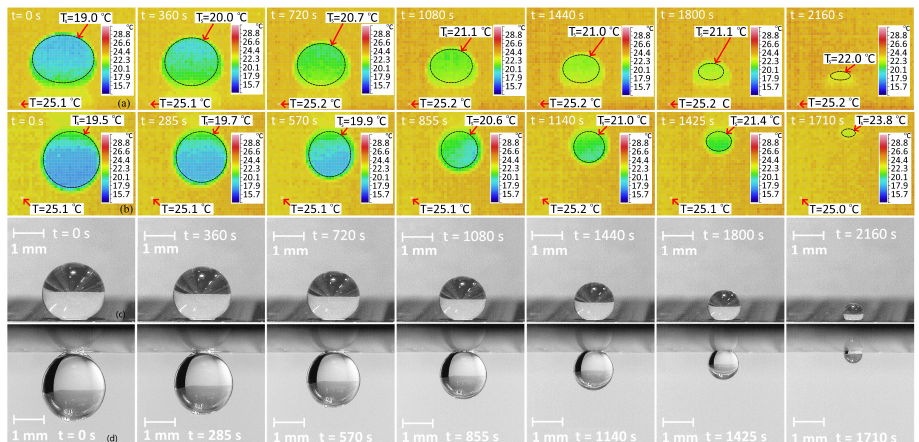
Figure 3. Thermal images of droplets: ( a ) sessile; ( b ) pendant. Change in the shape of evaporating droplets: ( c ) sessile; ( d ) pendant.